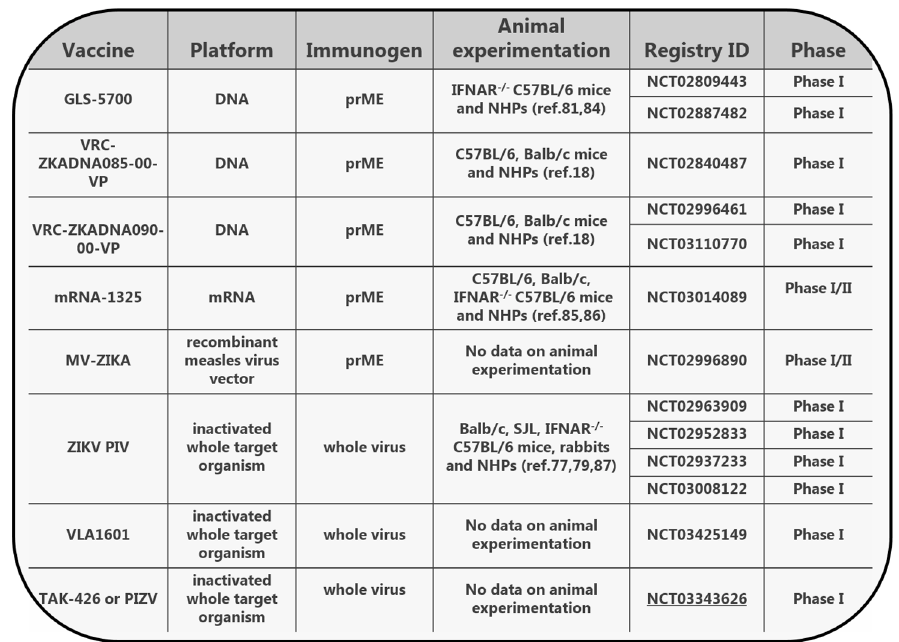
Figure 3. Overview of the ZIKV vaccines currently in clinical trials. Source: World Health Organization (WHO) vaccine pipeline tracker (https://www.who.int/immunization/research/vaccine_pipeline_tracker_spreadsheet/en/).